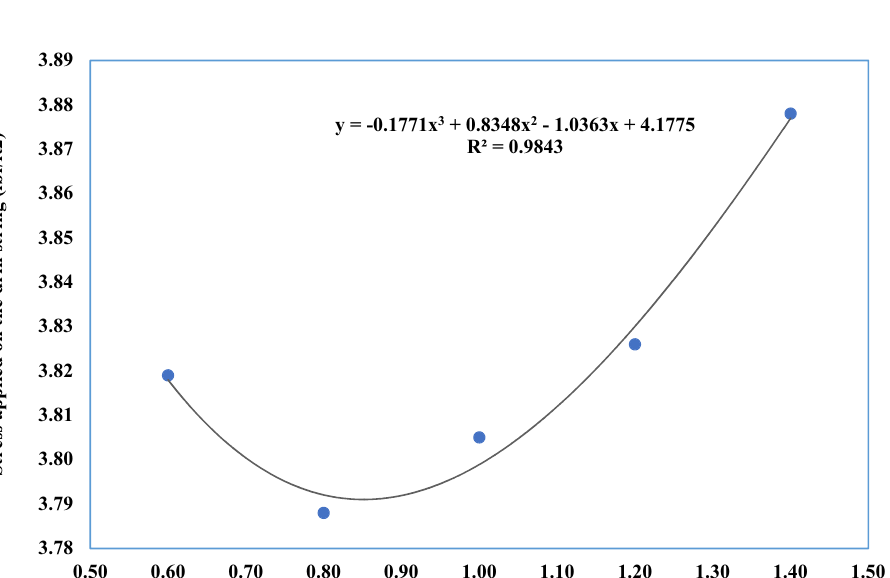
Cutting density/operational density (dimensionless)